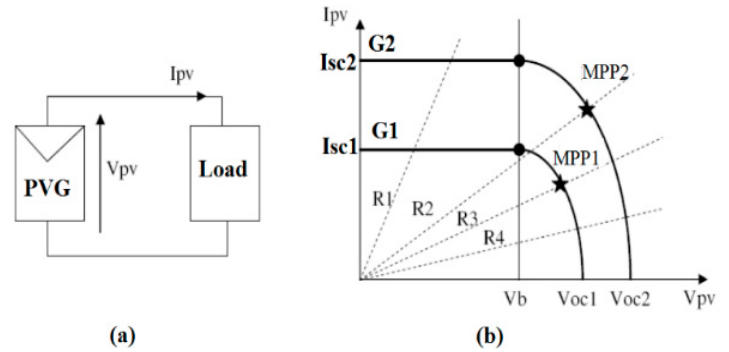
Figure 2. ( a ) Direct electrical connection between a PV generator and a load; ( b ) different operating points for two levels of radiation with different loads.